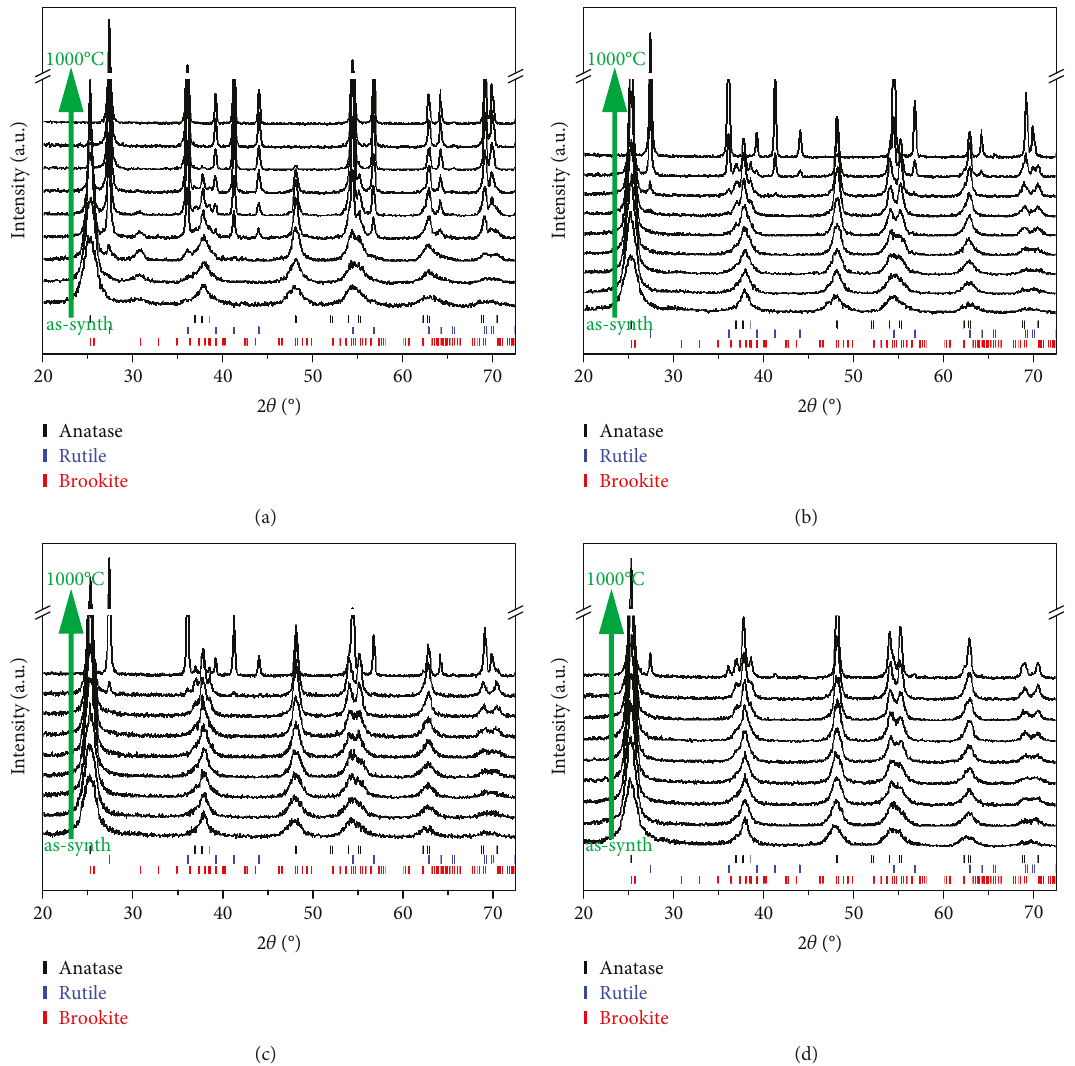
Figure 3: XRD patterns of as-synthesized and thermally treated samples at 300, 400, 500, 600, 700, 800, 900, and 1000 ° C (a) S0, (b) S3, (c) S5, and (d) S10.